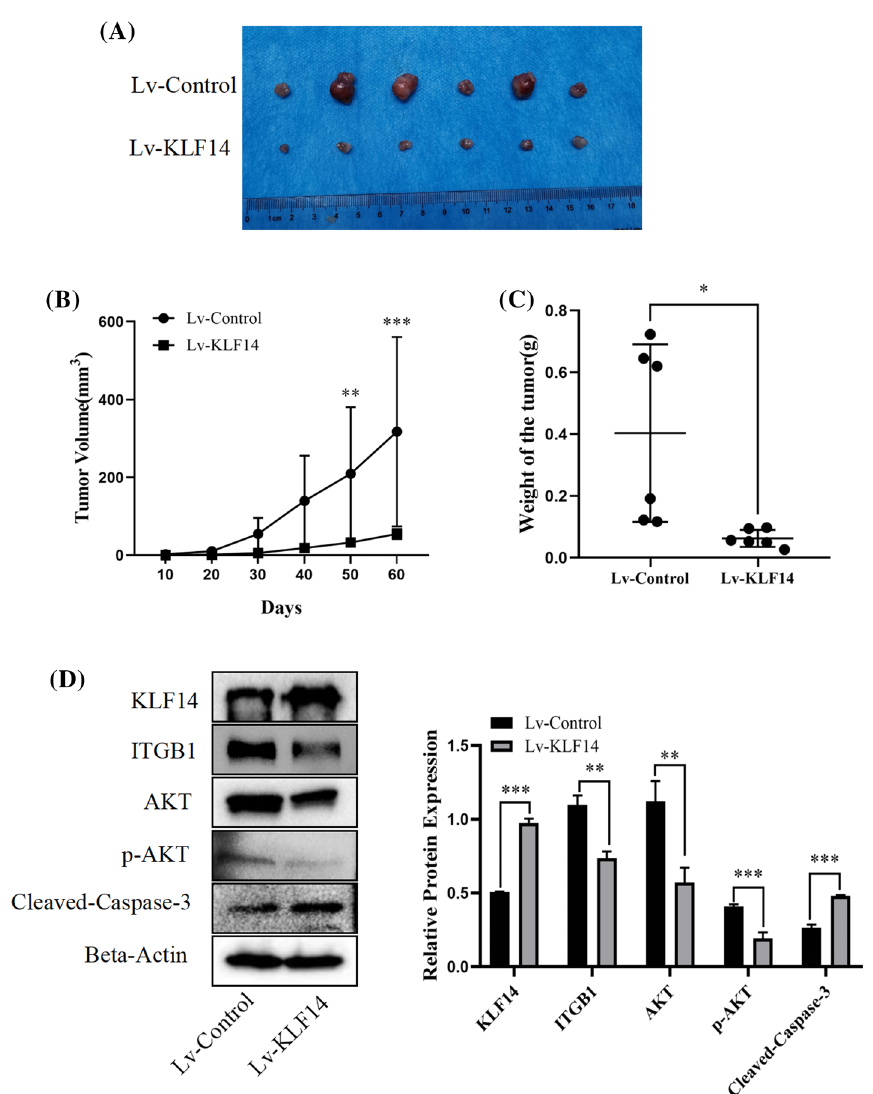
Fig. 3 KLF14 inhibited the progression of cervical cancer in vivo. A First, six groups were set up. The injection scheme was as follows: six nude mice were used, and the left and right sides of each nude mouse were compared. SiHa cells (5 × 10 6 cells/group) of the Lv-KLF14 group were injected subcutaneously into the axilla of the right upper limb of nude mice with 200 μl PBS suspension as the positive control. The Lv- control group was injected subcutaneously into the left upper arm axilla of nude mice with 200 μl PBS suspension as the negative control. Next, DOX, as an inducer, induced KLF14 expression in the Lv-KLF14 group, while KLF14 was not expressed in the Lv-control group, allowing for comparison. The induction scheme was as follows: before the injection, SiHa cells of the Lv-KLF14 group and Lv-control group were cul- tured in medium containing DOX (5 µg/ml) for 48 h. After the injection, the nude mice were fed water with DOX (1 mg/ml) for 1 week. After that, DOX-containing water was provided intermittently. Two months later, the nude mice were sacrificed, and the size of subcutaneous tumours in the Lv-KLF14 group was smaller than that in the Lv-control group. B Tumour growth was recorded every 10 days, and tumour volume was calculated using the formula V = (larger diameter) × (smaller diameter) 2 /2. The results showed that tumour growth was faster in the Lv-control group than in the Lv-KLF14 group. C The weight of subcutaneous tumours in the Lv-KLF14 group was lower than that in the Lv-control group. D According to the Western blot results, the expression of KLF14 and cleaved caspase-3 was upregulated and the expression of ITGB1 and p-AKT was downregulated in the Lv-KLF14 group compared with the Lv-control group in tumour tissues. (*P < 0.05, **P < 0.01, ***P <